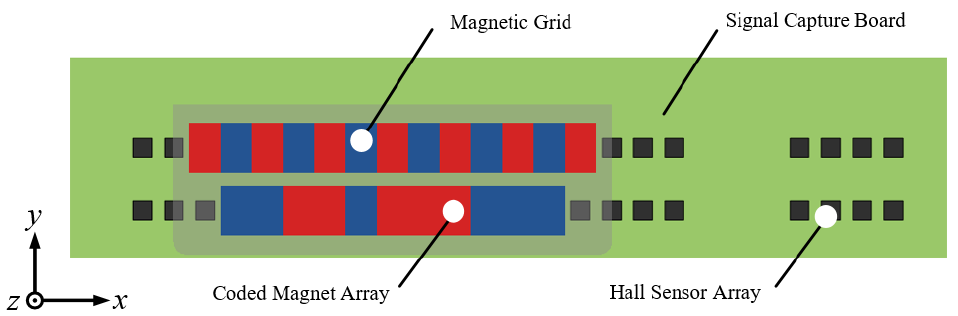
Figure 1. Schematic diagram of the sensor structure.